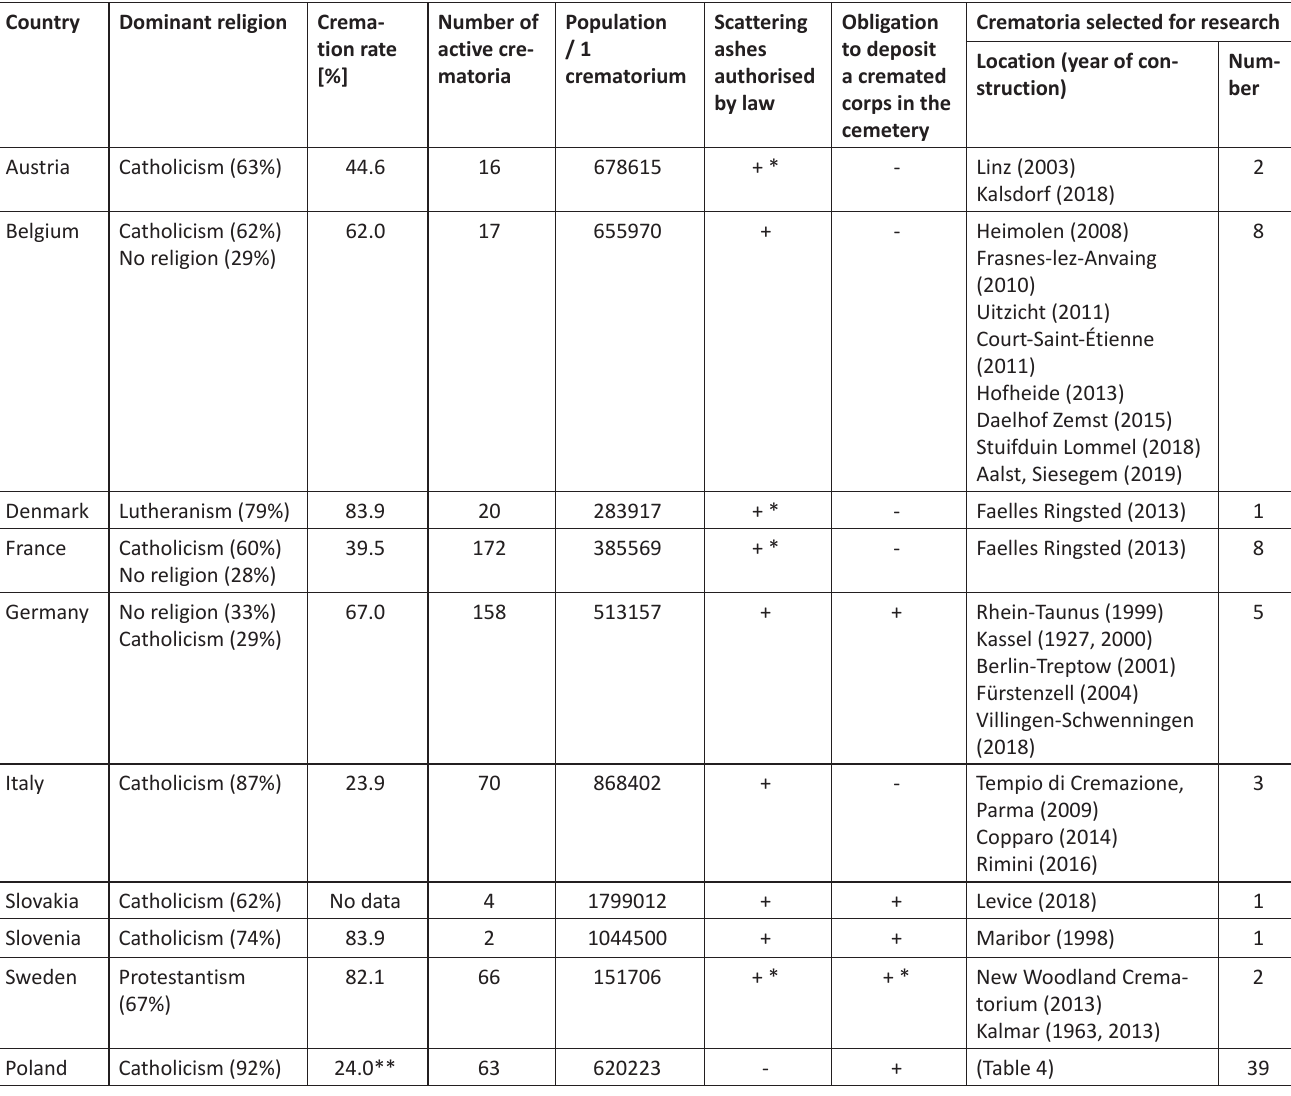
Table 3. List of European countries with selected crematoria. Own